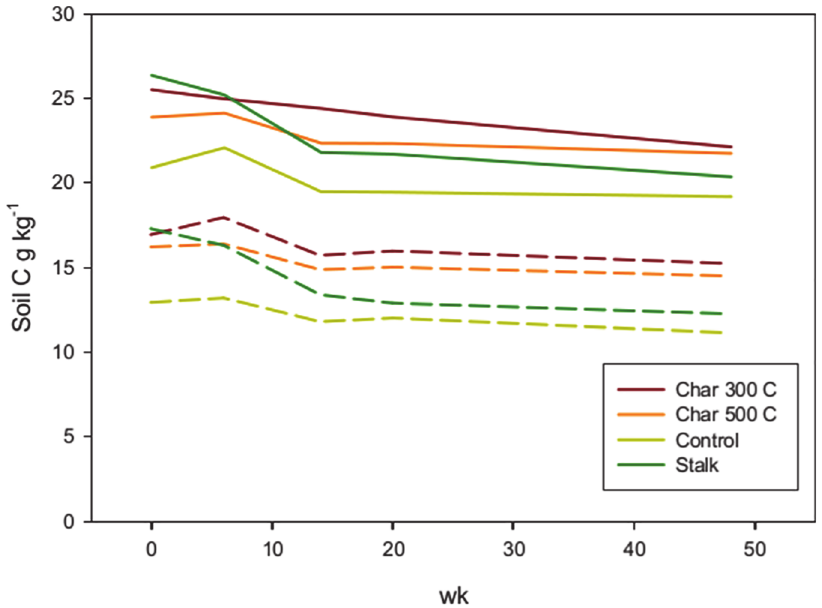
Fig 3. Soil C dynamics during the incubation of the low-erosion (dashed lines) and high-erosion soils (solid lines).